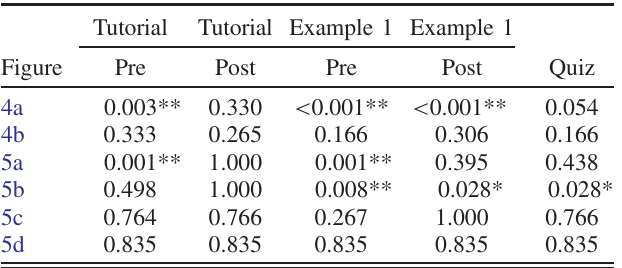
TABLE IV. A list of p values from Fisher ’ s exact test comparing the performance of 2018 students and matched 2017 students on each common assessment in the listed figure. The p values have been adjusted using the Benjamini-Hochberg method [30]. Significant ( p < 0 . 05 ) and highly significant ( p < 0 . 01 ) values are marked using * and **,